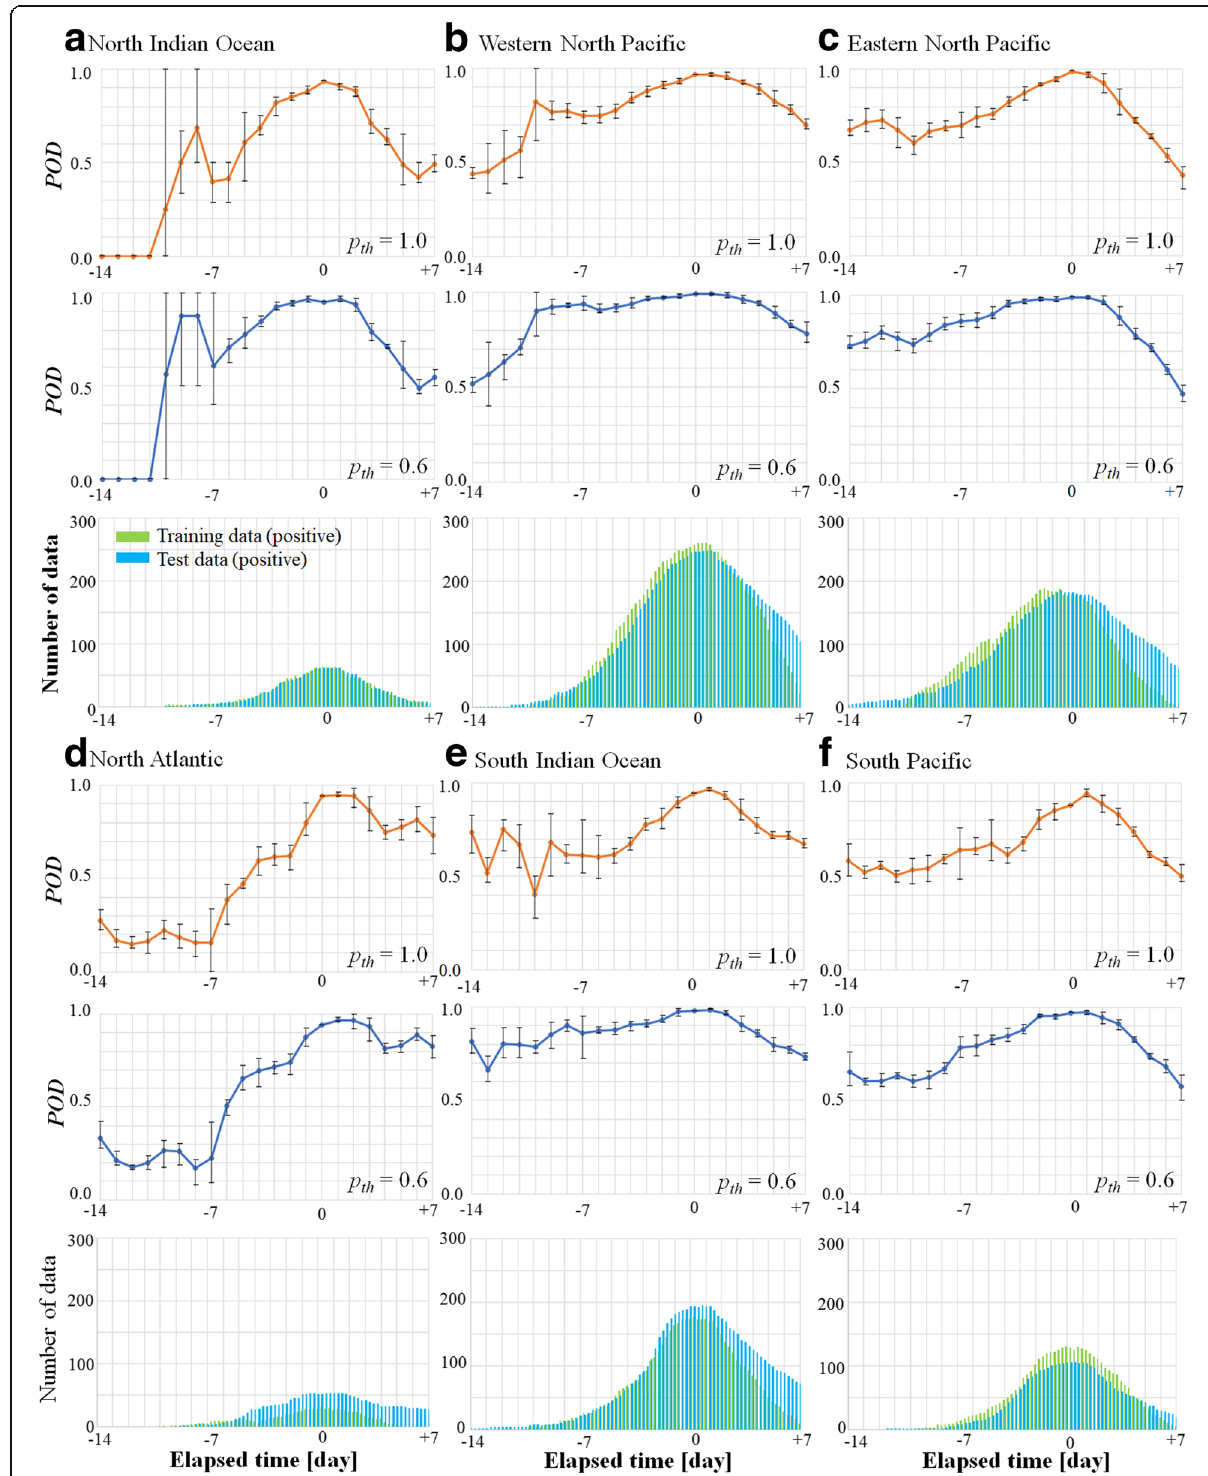
Fig. 10 Average-max-min charts of POD ( p th = 1.0 and p th = 0.6) and bar graphs of the number of data (training and test data) for each elapsed time frame in each